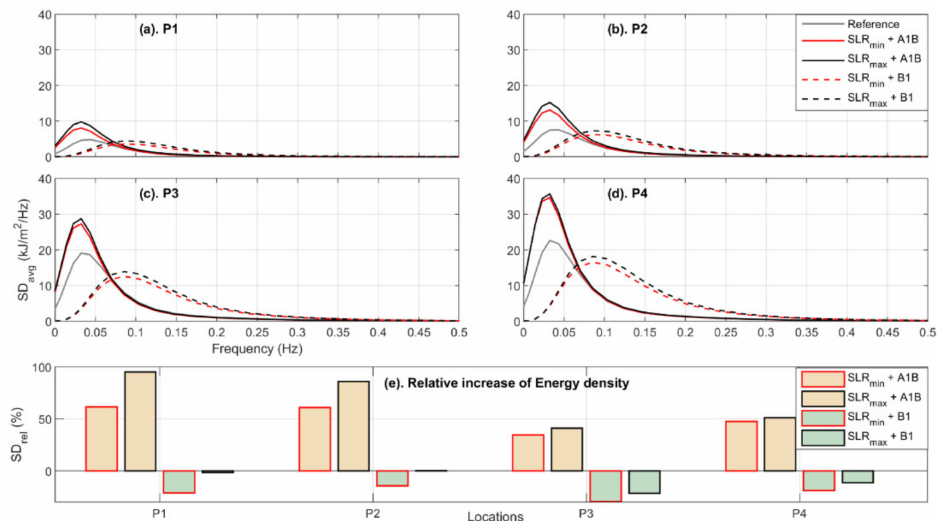
Figure 11. Average wave energy density spectrum ( SD avg ) during the analysis period from 7 January– 18 February 2013 for the reference (gray line), SLR min + A1B (red), SLR max + A1B (black), SLR min + B1 (red-dashed), and SLR max + B1 (black-dashed) at P1: 0 m depth ( a ), P2: 2 m depth ( b ), P3: 4 m depth ( c ), and P4: 6.5 m depth ( d ) in the G3 domain (see Figure 10). ( e ) Relative increase in the wave energy density spectra with respect to the reference scenario ( SD rel